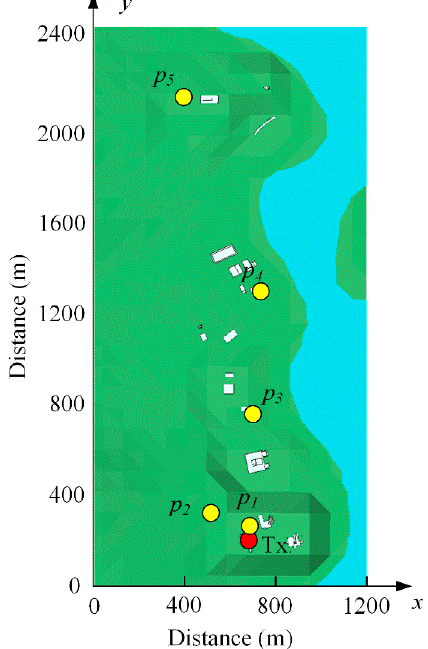
Figure 3. Simulation model for analysis area. Table 1. Coordinates of the main station and candidate positions of the relay stations.